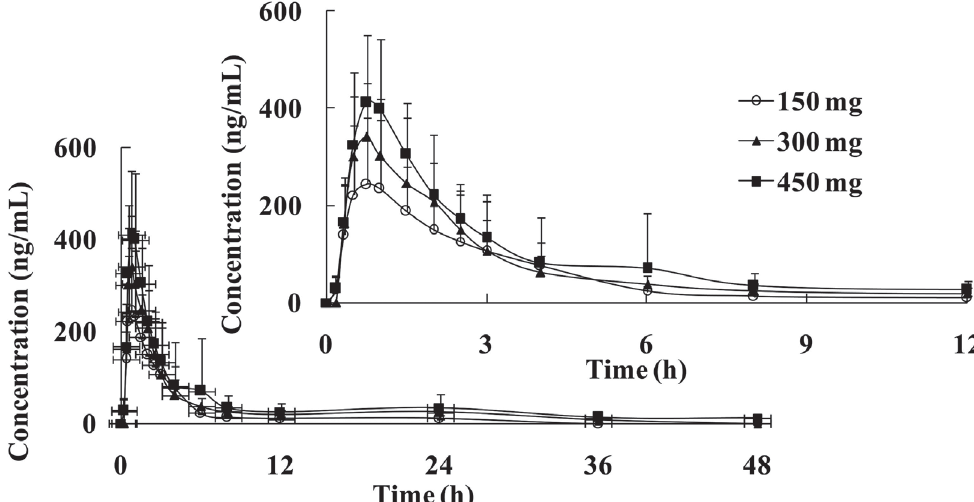
FIGURE 1 - Mean plasma concentration-time curves of MY-1250 in healthy Chinese subjects after a single oral administration of repirinast tablet 150, 300 or 450 mg (mean ± SD). TABLE III - Main pharmacokinetic parameters of MY-1250 after a single oral dose of repirinast tablet (mean ± SD)